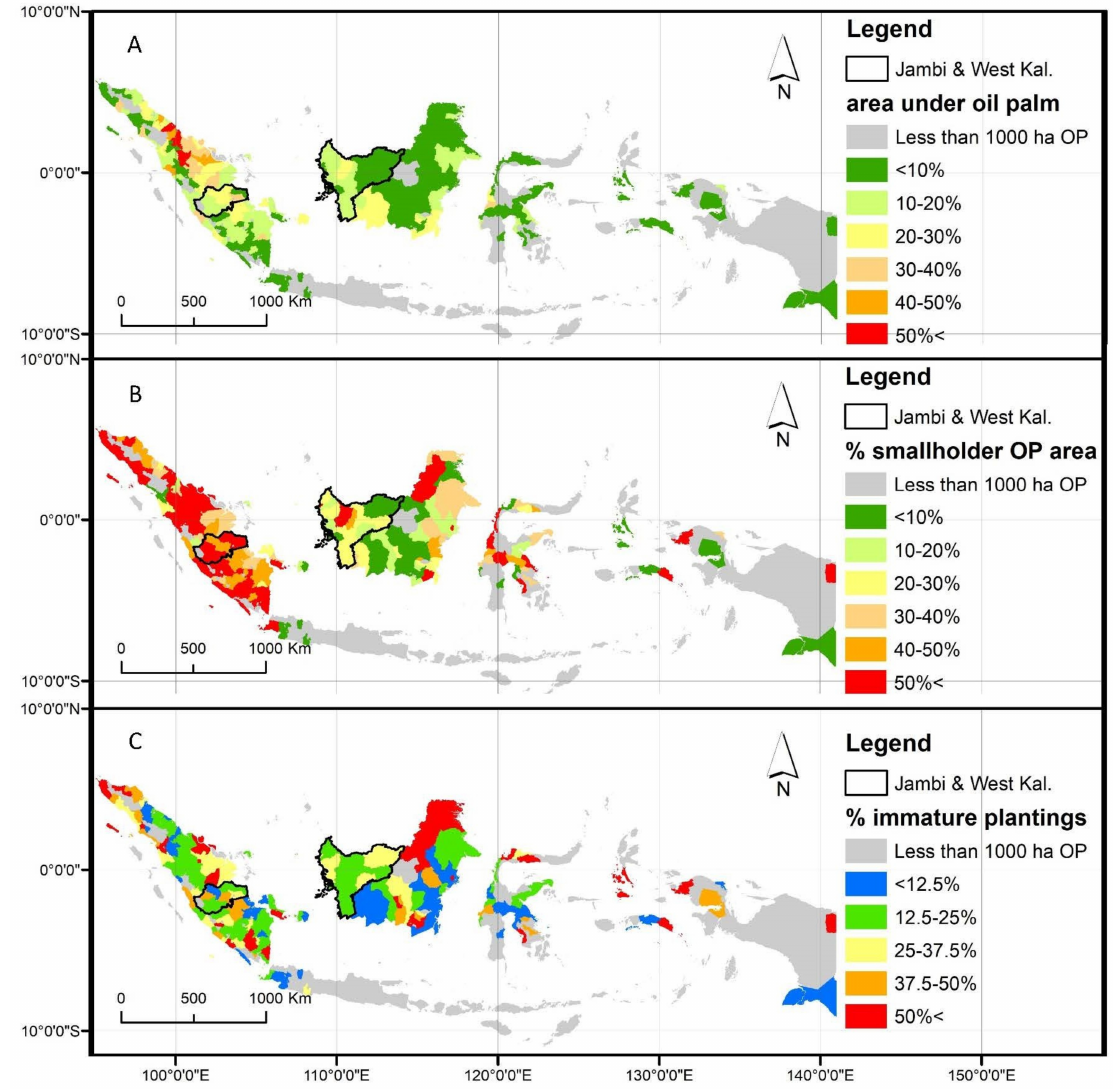
Figure 2. Maps on 2017 oil palm distribution at the district level in Indonesia, highlighting Jambi and West Kalimantan provinces; ( A ) Area fraction under oil palm; ( B ) Share of oil palm cultivated by smallholders; ( C ) Share of oil palm that does not yield yet as it is too young (usually less than three years old); Sources: Own maps, oil palm data from [79]; district boundary and area data from [80]. Several authors have quantified oil palm development within the forest zone in Indonesia